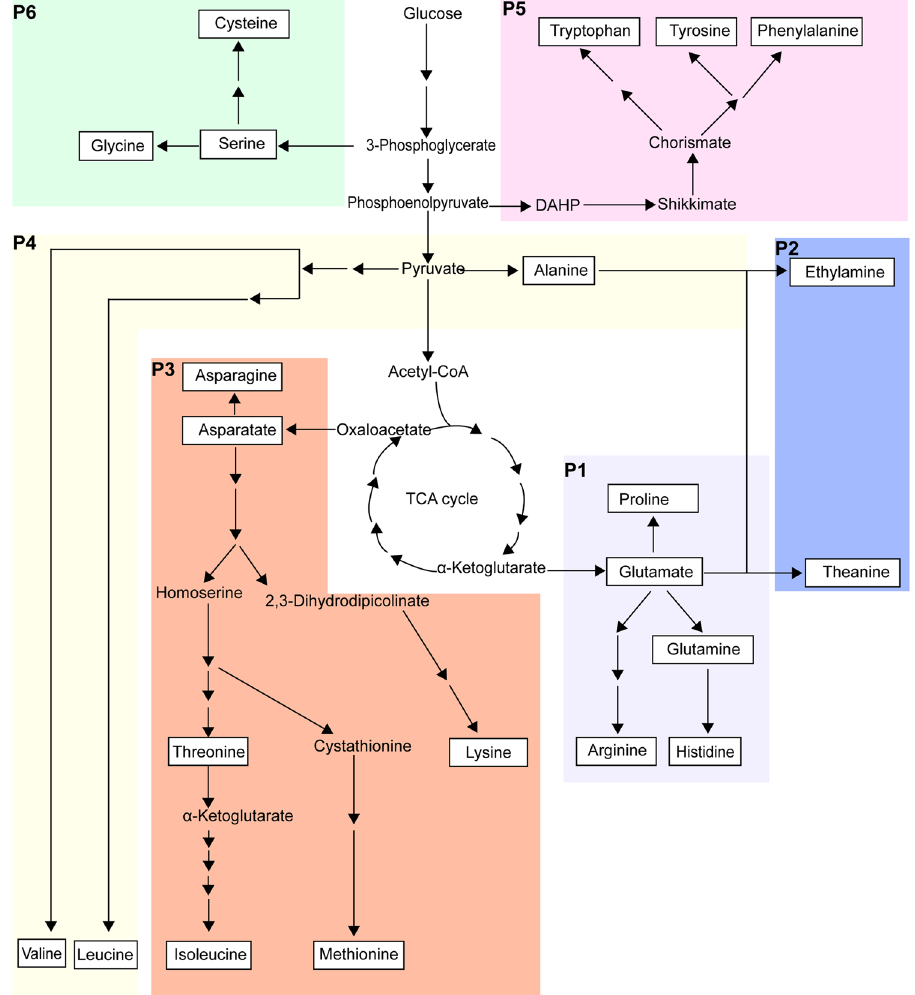
Figure 1. Schematic diagram of amino acid metabolism pathways in tea plants. P1&2, amino acids were derived from Glu pathway consisting of Glu, Gln, Arg, Pro and Thea. P3, amino acids were derived from Asp pathway consisting of Asp, Thr, Ile, Met, Lys, Asn. P4, amino acids were derived from pyruvate pathway consisting of Val and Leu. P5, amino acids were derived from aromatic amino acid pathway consisting of Trp, Phe and Tyr. P6, amino acids were derived from 3-phosphoglycerate pathway consisting of Cys, Ser and Gly. Glu, glutamate; Gln, glutamine; Arg, arginine; Pro, proline; Thea, theanine; Asp, aspartate; Thr, threonine; Lys, lysine; Ile, isoleucine; Aspn, asparagine; Val, Valine; Leu, Leucine; Trp, tryptophan; Phe, Phenylalanine; Tyr, Tyrosine; Cys, cysteine; Gly, Glycine; Ser,